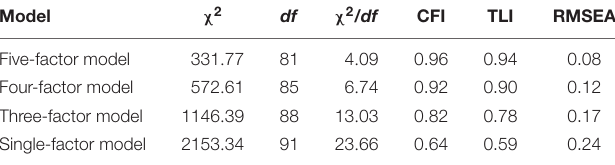
TABLE 1 | Results of